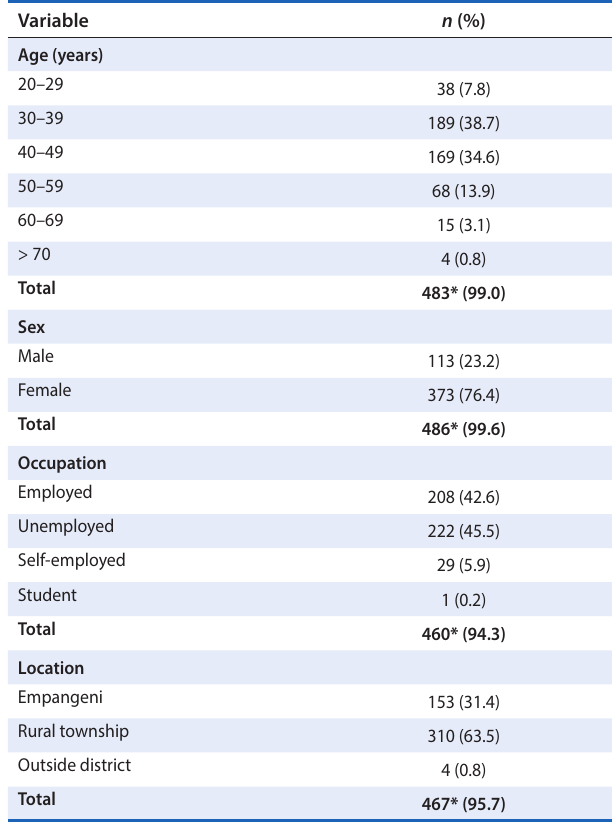
Table 1: The demographic profile of the study patients ( n = 488)